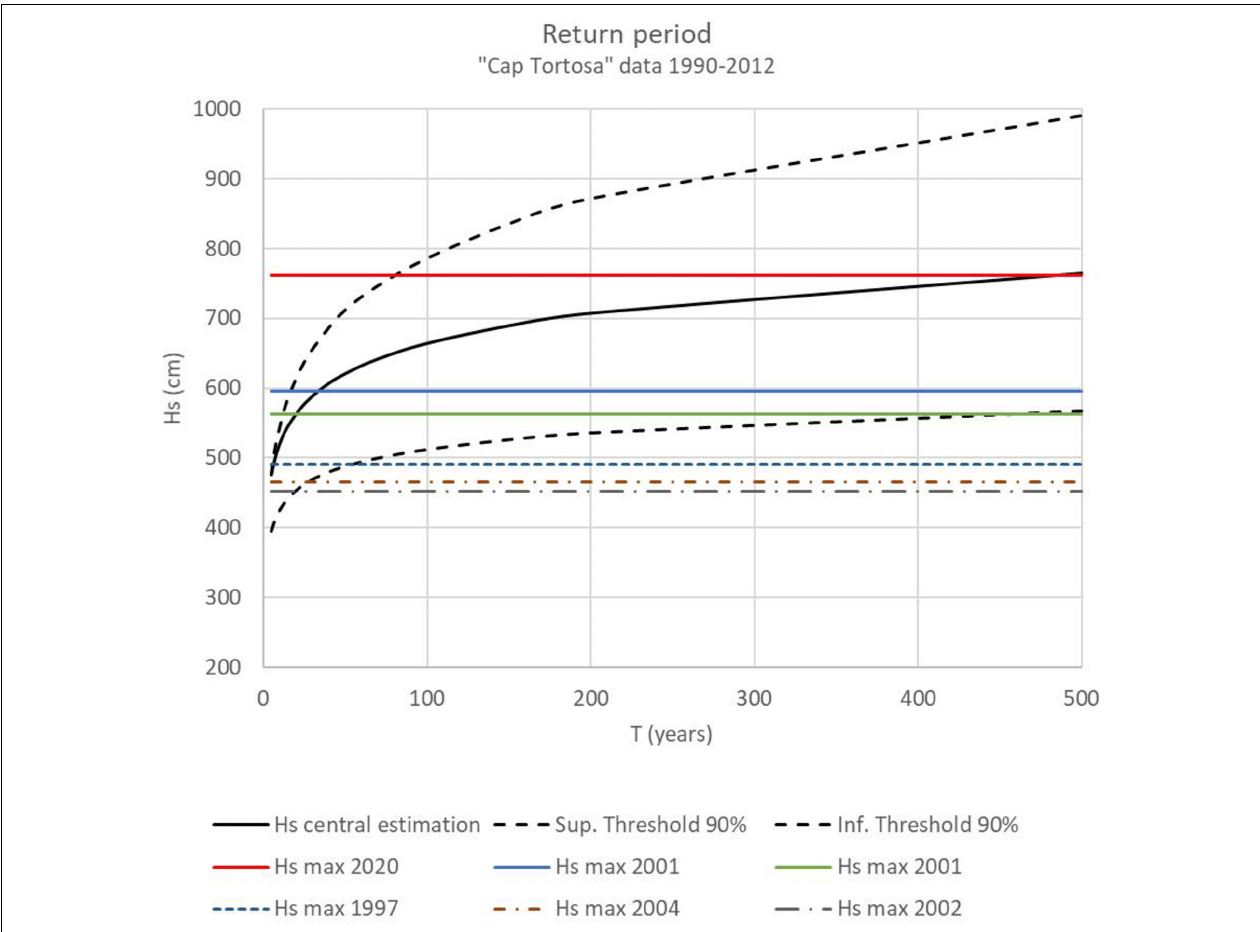
FIGURE 3 | Weibull extreme distribution function plotting significant wave height against return period. The data set corresponds to the period 1990–2012 recorded by the XIOM wave buoy station in front of the Ebro delta, at a depth of 60m and which was dismounted in 2012. Fit according to least squares and Goda’s formula for the relative frequencies, applying a threshold of 2.5 m to define wave storms for the extreme